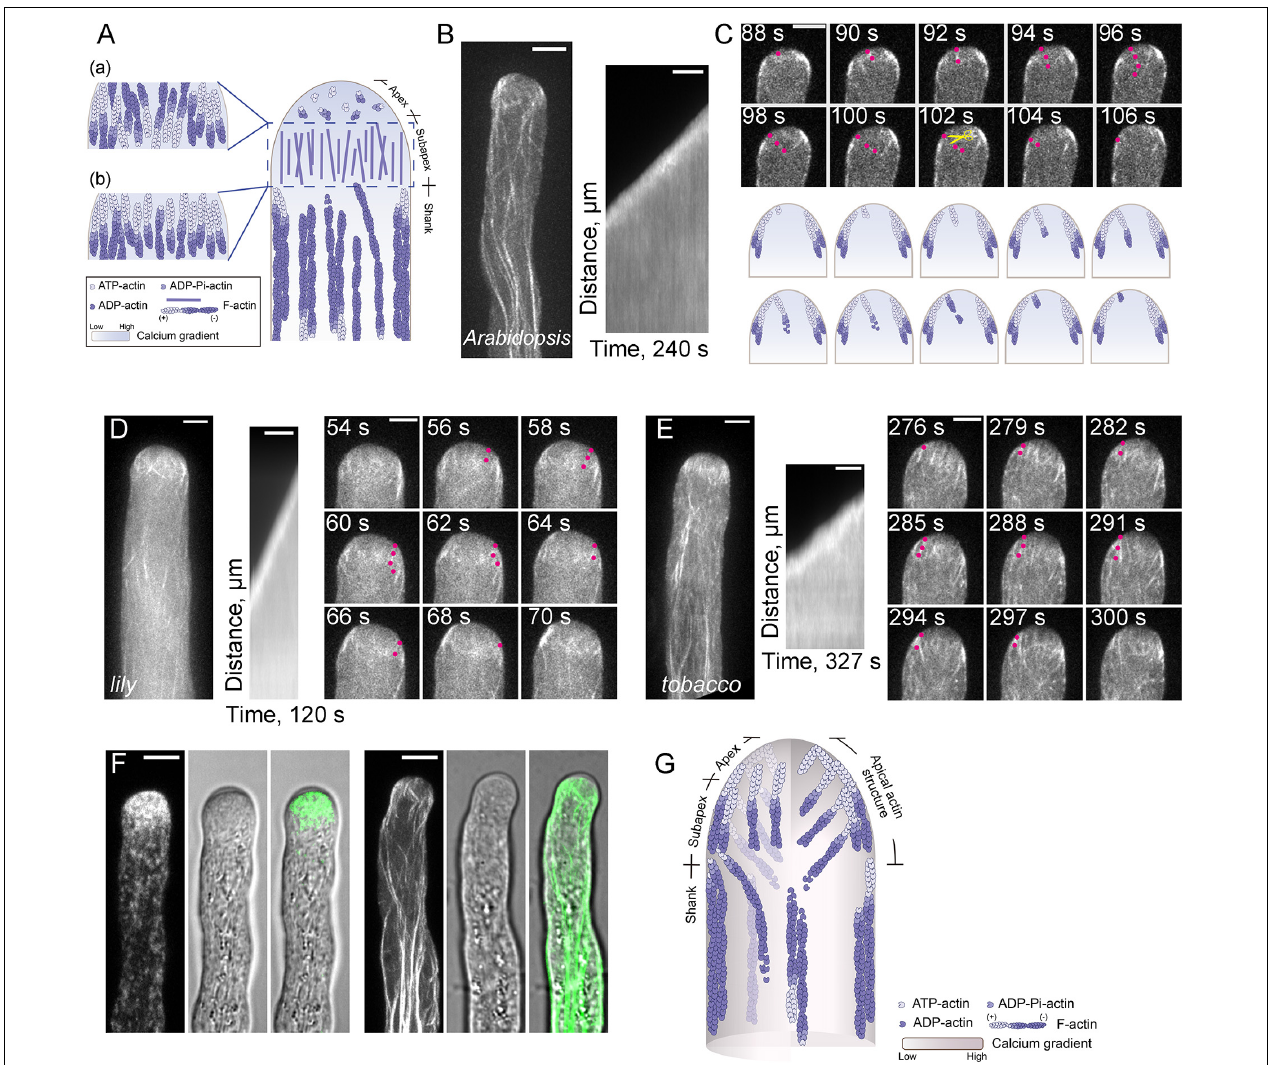
FIGURE 1 | Actin Filaments are Continuously Polymerized from the Plasma Membrane within the Apical and Subapical Regions of the Pollen Tube. (A) Schematic diagram depicting our previous understanding of the spatial distribution of actin filaments in the pollen tube. This model refers to the models shown in previous review articles with slight modifications (Vidali and Hepler, 2001; Lovy-Wheeler et al., 2005; Ren and Xiang, 2007; Cheung and Wu, 2008; Yang, 2008; Cai and Cresti, 2009; Qin and Yang, 2011; Guan et al., 2013; Rounds and Bezanilla, 2013; Cai et al., 2015; Fu, 2015; Bascom et al., 2018). Specifically, actin filaments are arrayed into longitudinally oriented actin bundles in the shank and in the actin fringe structure at the subapex. In terms of the polarity of actin filaments within the actin fringe, the models in (a,b) were drawn with reference to Ren and Xiang (2007); Cheung and Wu (2008), and Qin and Yang (2011), respectively. By comparison, actin filaments at the apex are short, less abundant and disorganized. (B) Actin filaments are polymerized from the plasma membrane in an Arabidopsis pollen tube tip. The right panel shows the kymograph analysis of apical actin filaments decorated with Lifeact-eGFP in the growing wild-type (WT) Arabidopsis pollen tube shown in the left panel. Scale bar = 5 µ m. (C) Time-lapse images of apical actin filaments in the pollen tube shown in (B) . Red dots indicate an actin filament that is polymerized from the plasma membrane, then grows into the inner region of the pollen tube. The yellow scissors indicate a severing event of the same actin filament. Scale bar = 5 µ m. The lower panel shows a schematic depiction of the events in the upper panel. (D,E) Actin filaments polymerized from the plasma membrane at the tip of a growing lily (D) and tobacco (E) pollen tube. In each figure, the left panel shows the Z-projection image of actin filaments in the pollen tube. The middle panel shows kymograph analysis of actin filaments growing from the plasma membrane at the pollen tube tip, and the right panel shows some time-lapse images of actin filaments in the growing pollen tube shown in the left panel. Red dots indicate an actin filament that was polymerized from the plasma membrane, then grew into the inner region of the pollen tube. Scale bar = 5 µ m. (F) Visualization of RabA4b-positive transport vesicles (left panel) and actin filaments (right panel) in WT Arabidopsis pollen tubes. Transport vesicles accumulate within the region corresponding to the clear zone at the pollen tube tip (left panel). Actin filaments at the base of the clear zone, which polymerize from the plasma membrane, correspond to the actin fringe at the subapex shown in (A) . Scale bar = 5 µ m. (G) Schematic depiction of our current view of the organization of actin filaments in the Arabidopsis pollen tube. Similar to the model shown in (A) , actin filaments are organized into actin bundles oriented longitudinally in the shank region. Within the apical and subapical regions of the pollen tube, actin filaments are polymerized from the plasma membrane. These filaments can be viewed as a whole and defined as the “apical actin structure.” Membrane-originated actin filaments within this “apical actin structure” assume a distinct spatial distribution, with some cortical actin filaments forming thick actin bundles, while some inner actin filaments are comparatively fine and extend toward the inner region of the cytoplasm.